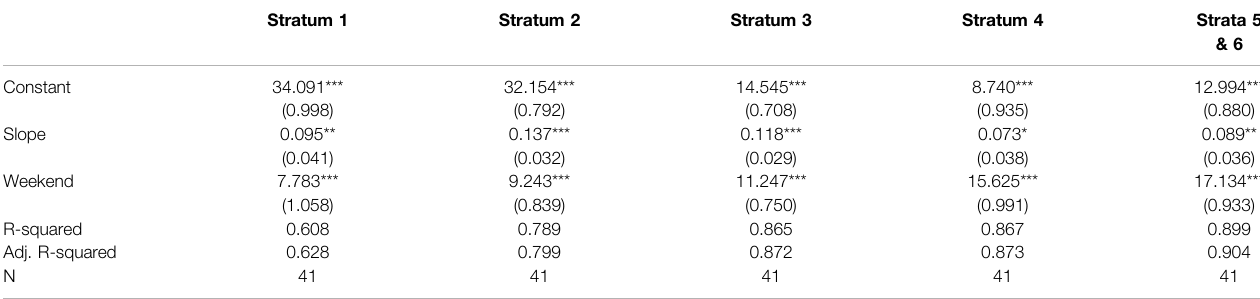
TABLE 3 | OLS estimation. Dependent variable is the transactions reduction(%). Estimation period:Sep/01 to Oct/12 (41 days). Stratum 1 Stratum 2 Stratum 3